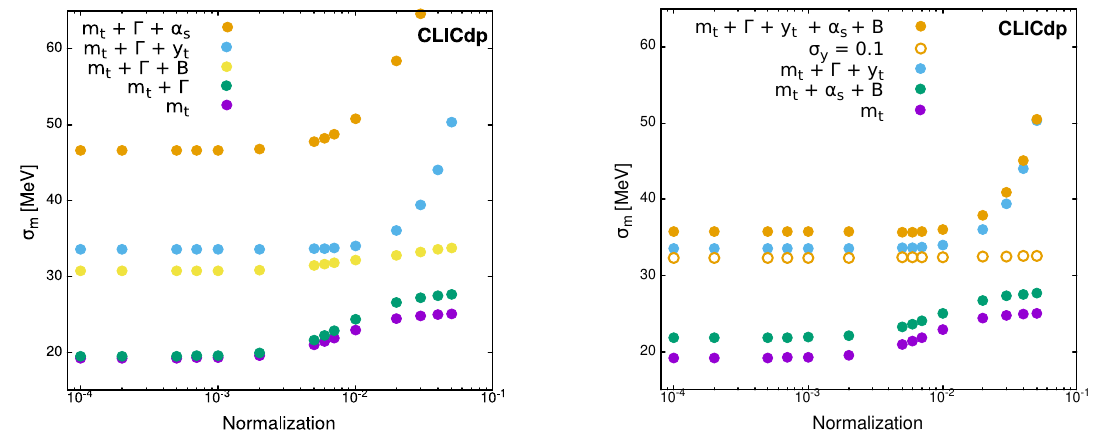
Figure 6 . Statistical uncertainty on the top-quark mass as a function of the assumed overall normalisation uncertainty for different fit configurations. Left: without any additional parameter constraints. Right: for “SM constrained” mass fit ( m ) and the fit of mass, width and Yukawa t coupling ( m + Γ + y ), without and with systematic parameters and their constraints included in t t t the fit; results of the fit with additional constraint on the Yukawa coupling are also indicated, see text for